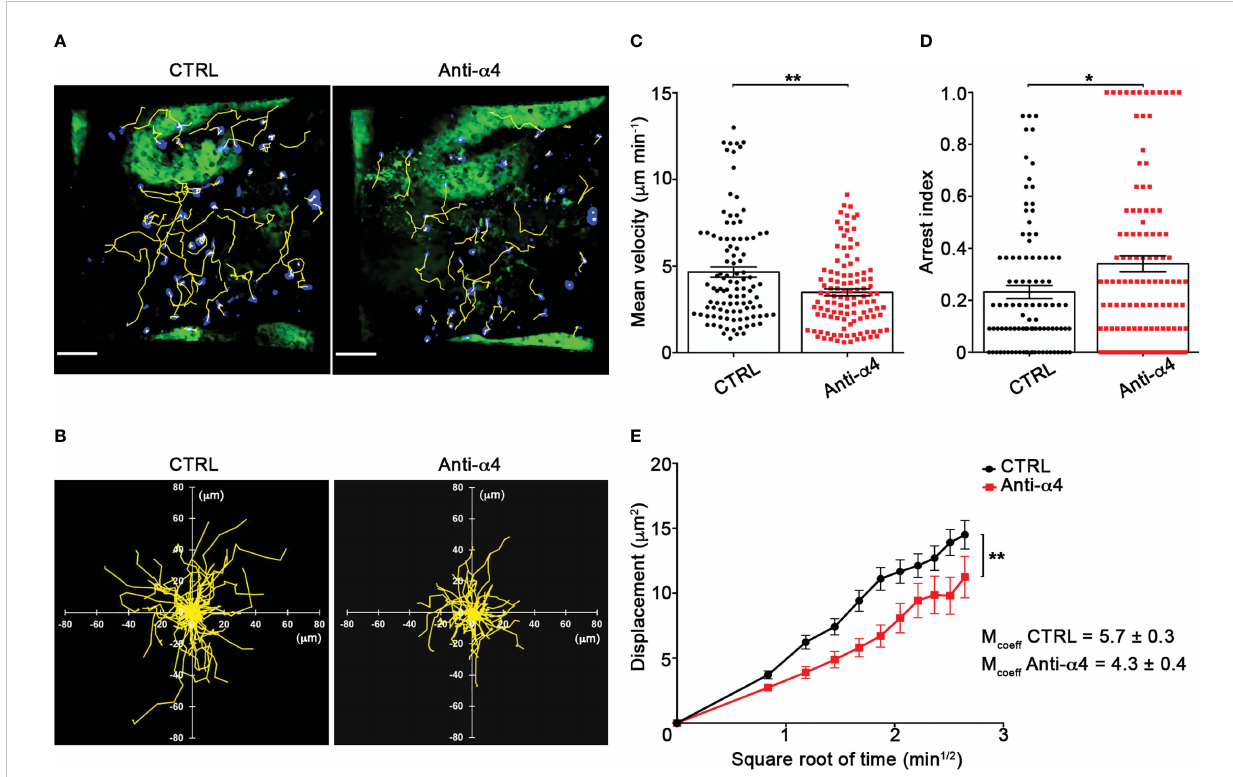
FIGURE 6 a 4 integrins control Th17 cells motility in the spinal SAS at disease peak. In vitro differentiated Th17 cells were fl uorescently labeled and intravenously injected at disease onset. TPLSM imaging was performed after 48 h, when mice reached the disease peak. (A) Representative images of Th17 cells before (CTRL) and after 30 min of anti- a 4 integrin treatment (anti- a 4 antibody) (scale bar = 50 m m). (B) Normalized trajectories of 70 Th17 cells over 12 time points before and after anti- a 4 antibody. (C) Mean velocity (** P = 0.0095) and (D) arrest index (* P = 0.0149) of Th17 cells before and after a 4 integrin blockade. Statistical signi fi cance was calculated using the Mann – Whitney test (* P < 0.05). (E) Mean displacement of Th1 cells is signi fi cantly reduced after anti- a 4 blocking antibodies (After linear regression application, the differences between slopes resulted statistically signi fi cant; ** P = 0.0072). All data are expressed as mean ± SEM. A total of 104 cells were analyzed for CTRL and 111 after anti- a 4 treatment from two independent experiments. Track lower than 12 time points were excluded from the